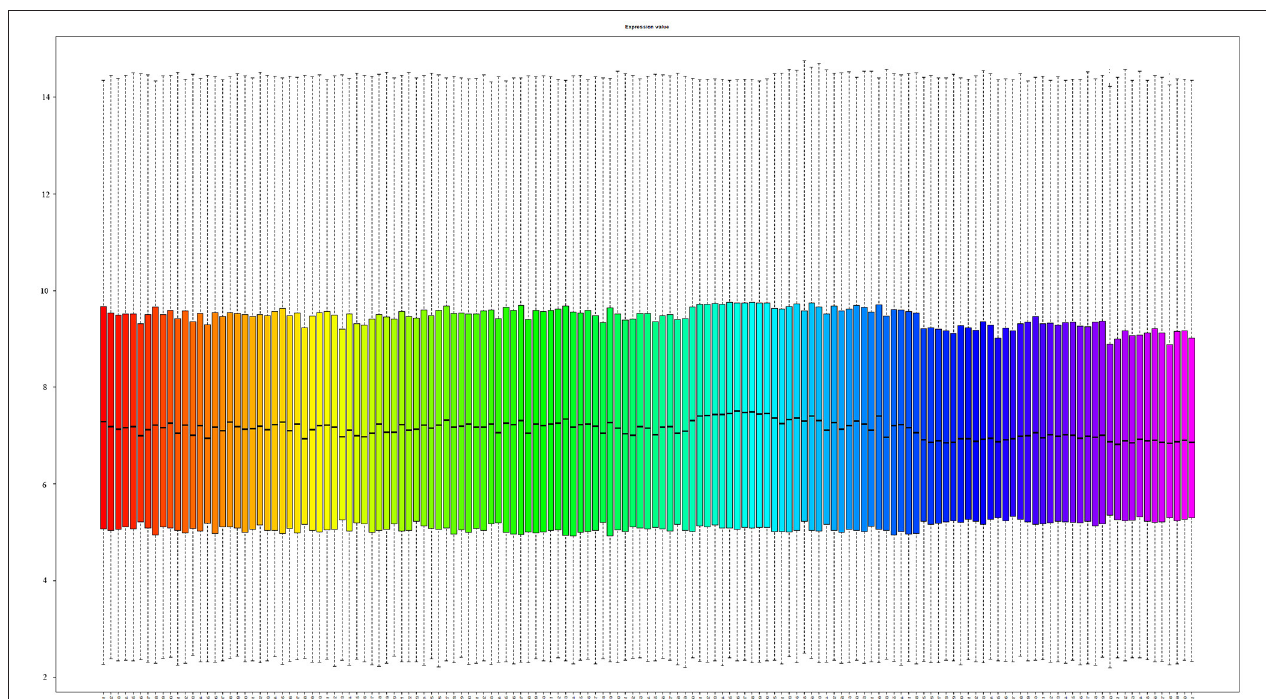
FIGURE 1 | Boxplot of 147 gene chips. The median gene expression of 147 samples is almost at the same level.